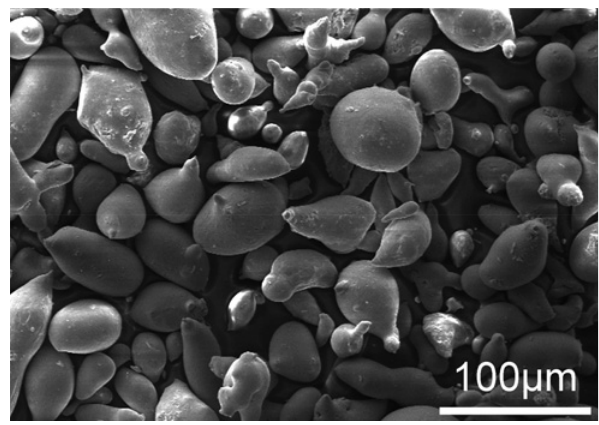
Figure 1: The morphology of the feedstock